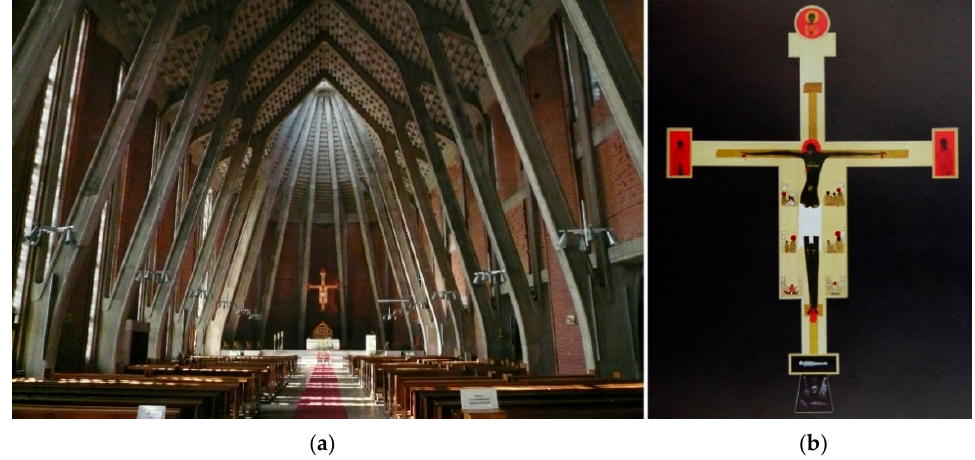
Figure 18. St. Dominic church in Warsaw: ( a ) overall view. Photography by Traper Bemowski. Image in the public domain. ( b ) The altar cross-designed by Jerzy Nowosielski. Photography by the author.